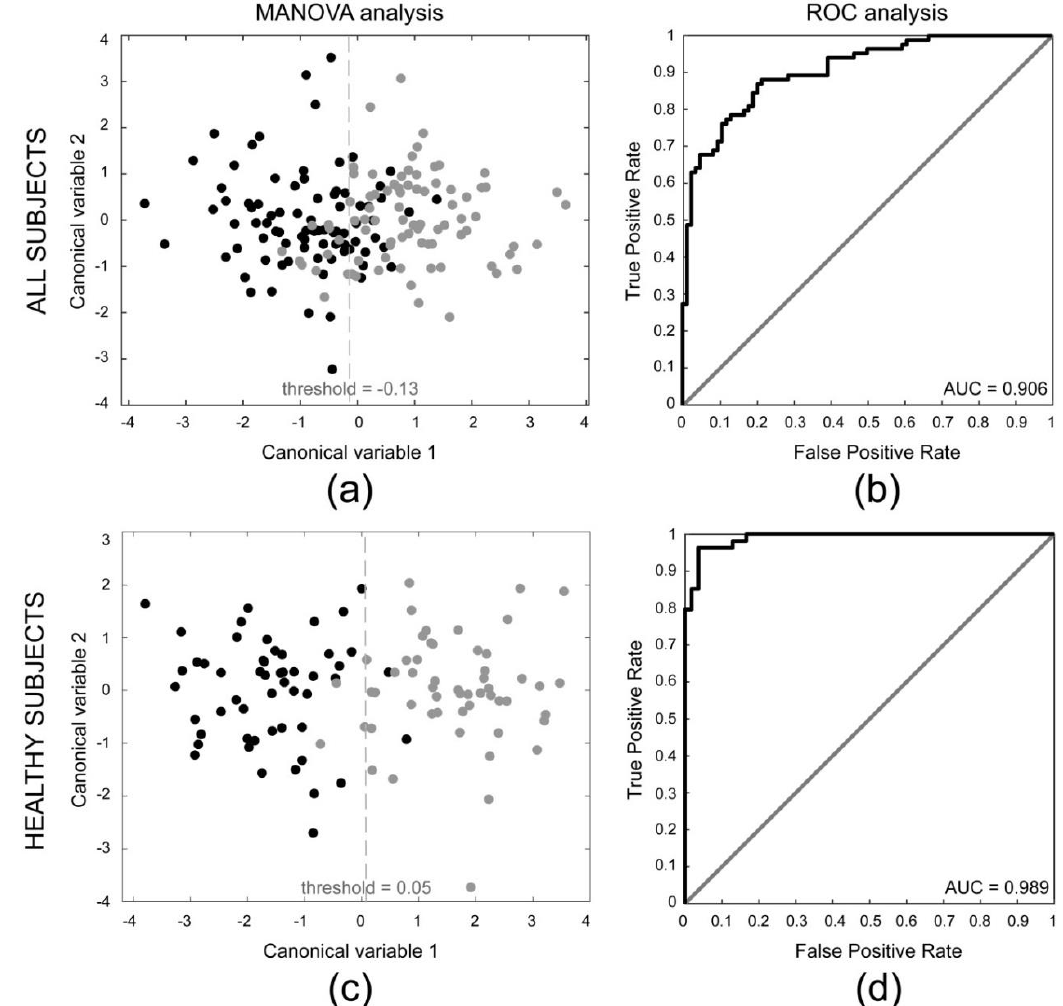
Figure 3. Results obtained when comparing dominant and non-dominant side texture features considering all subjects ( first row ) and only subjects with normal tendon structure ( second row ). The black circles represent the dominant side textures features, while the gray circles represent the non-dominant side texture features. ( a ) Representation of all subjects in the plane of the first two canonical variables obtained by a MANOVA analysis. The vertical gray dotted line represents the optimal threshold used (maximum Youden index) to obtain the sensitivity (86.9%), specificity (79.8%), and accuracy (83.3%) results; ( b ) ROC analysis results demonstrating the classification quality of the first MANOVA canonical variable, with an AUC equal to 0.906; ( c ) Representation of the healthy subjects in the plane of the first two canonical variables obtained by a MANOVA analysis. The vertical gray dotted line represents the optimal threshold used (maximum Youden index) to obtain the sensitivity (96.3%), specificity (96.3%), and accuracy (96.3%) results; ( d ) ROC analysis results demonstrating the classification quality of the first MANOVA canonical variable, with an AUC equal to 0.989.